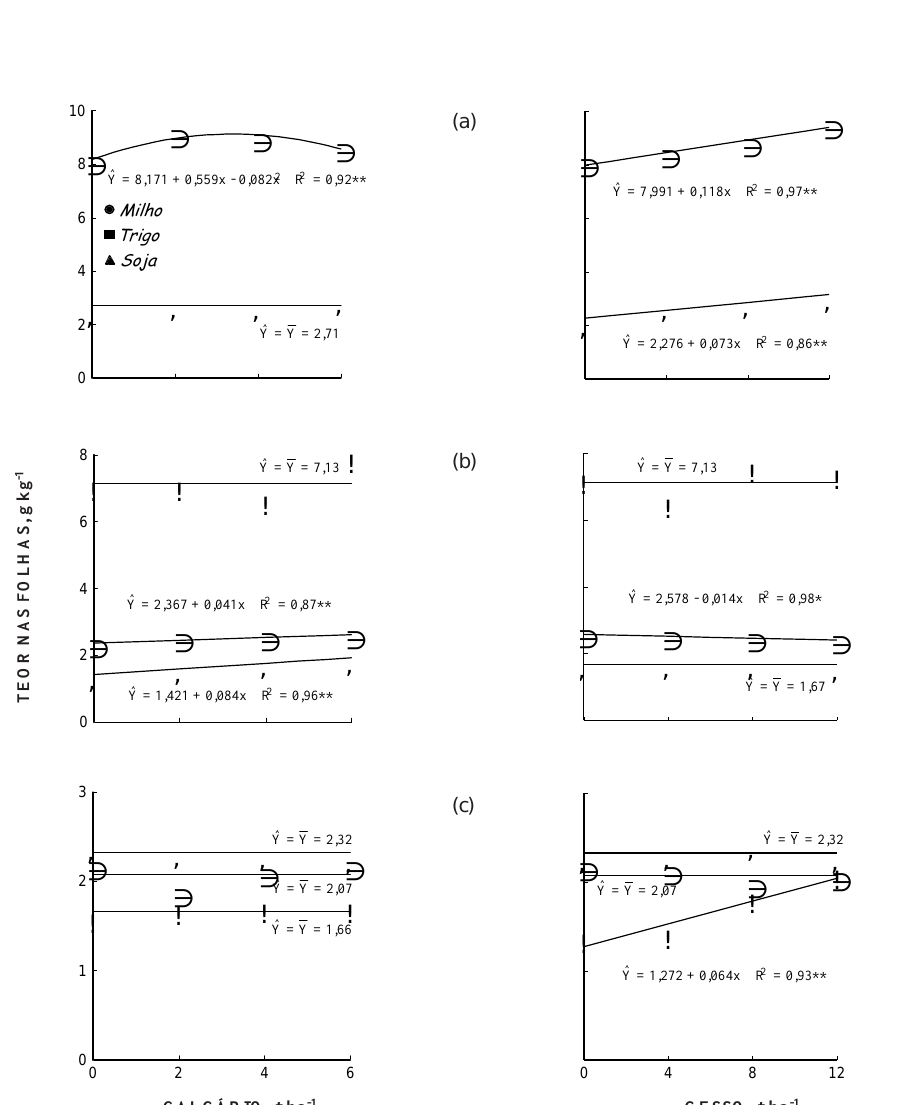
Figura 7. Efeito da calagem e da aplicação de gesso sobre os teores de cálcio (a), magnésio (b) e enxofre (c) nas folhas de milho, trigo e soja. Pontos são médias de quatro doses de calcário ou gesso. *, ** significativos a 5 e 1%,